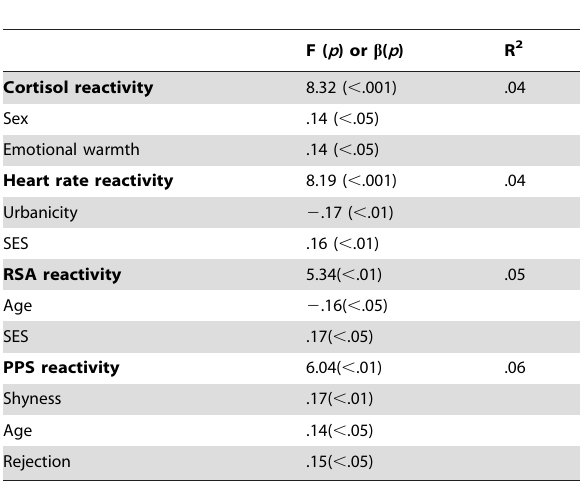
Table 4. Results of the multiple linear regression models, predicting each stress response in the child sample.